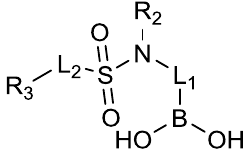
Figure 12. General structure of compounds claimed in